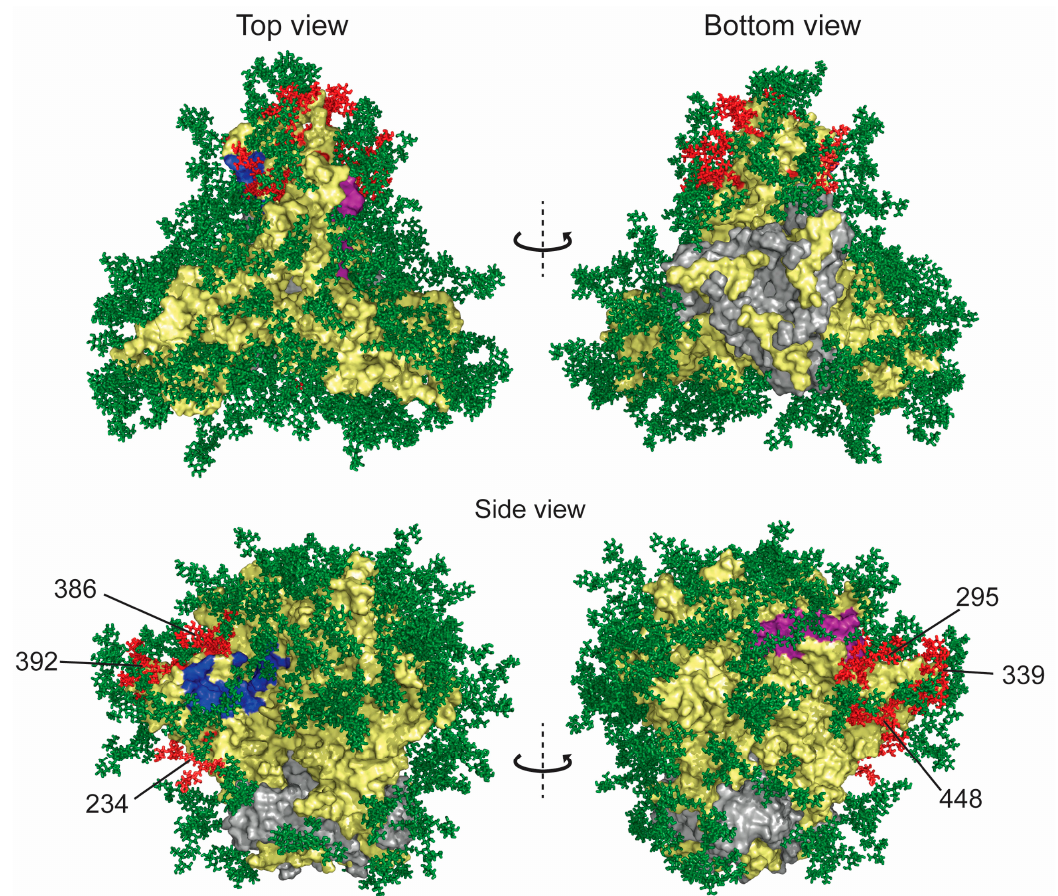
Figure 4. Structure of glycosylated HIV-1 gp120 trimer with full-length glycans modeled onto the protein. The surface envelope glycoprotein gp120 and transmembrane protein gp41 are shown as yellow and gray surfaces, respectively. CD4 receptor and co-receptor binding sites are colored blue and purple, respectively. Glycans found to be deleted in resistance studies are colored red (glycans 234, 295, 339, 386, 392 and 448). Other glycans shown to be deleted in GRFT-resistant strains but not present in this structure include glycans 230, 241 and 298. Model was rendered with Pymol. Model was constructed by C. Soto, PDB Accession Number 5FYK [44] and rendered with